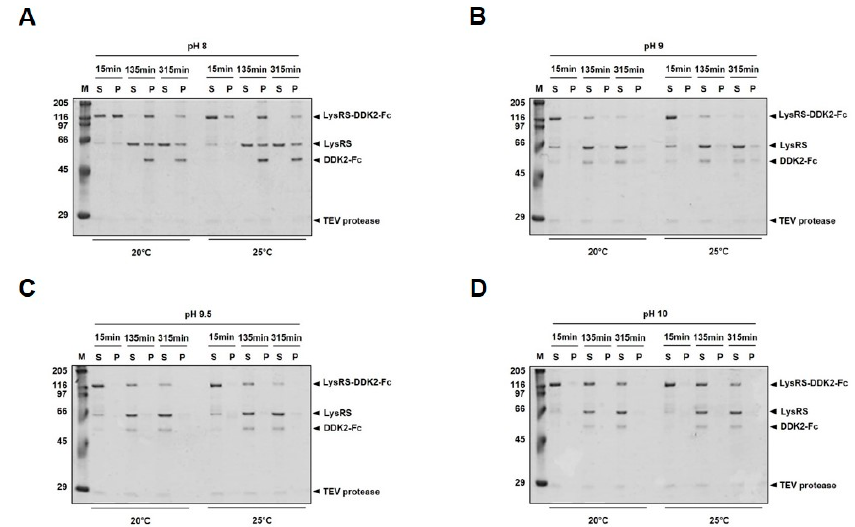
Figure 2. Cleavage of LysRS-DKK2-Fc by TEV protease. TEV protease cleavage of purified LysRS- DKK2-Fc in ( A ) pH 8.0, ( B ) pH 9.0, ( C ) pH 9.5 and ( D ) pH 10.0 buffer. The solubility of TEV-cleaved LysRS-DKK2-Fc protein was analyzed by SDS-PAGE.